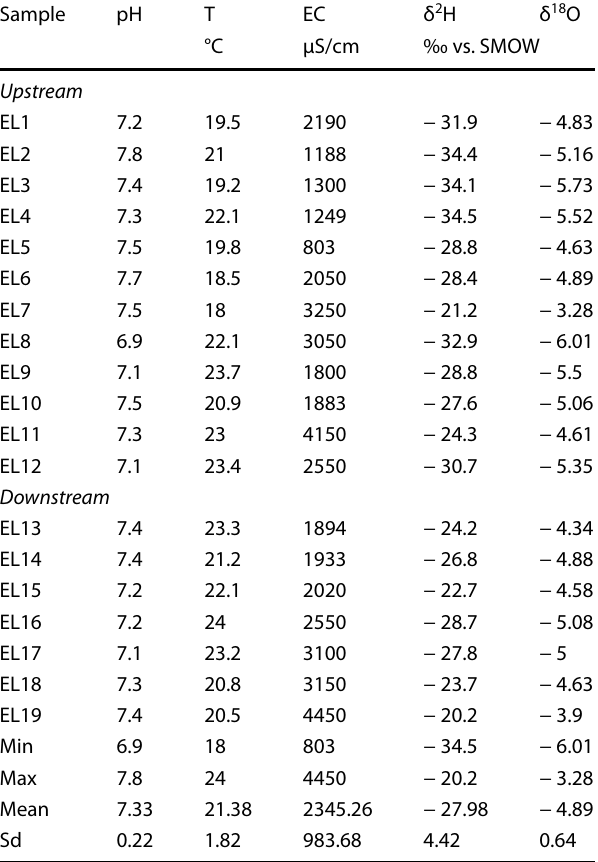
Table 2 Isotopic composition of analysed samples campaign 2016 in Meskala–Ouazzi sub-basin